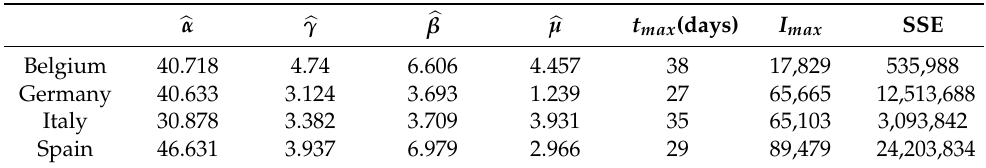
Table 2. Parameter estimates for the model ruled by Equation (1) (unit of time t : year). The SSE is the value of the optimization criterion in Equation (16).